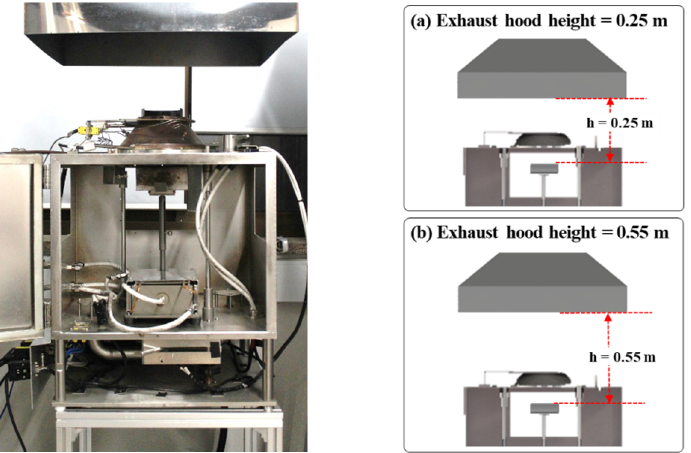
Figure 2. Photographs of a cone heater and the schematics of exhaust hood heights considered.